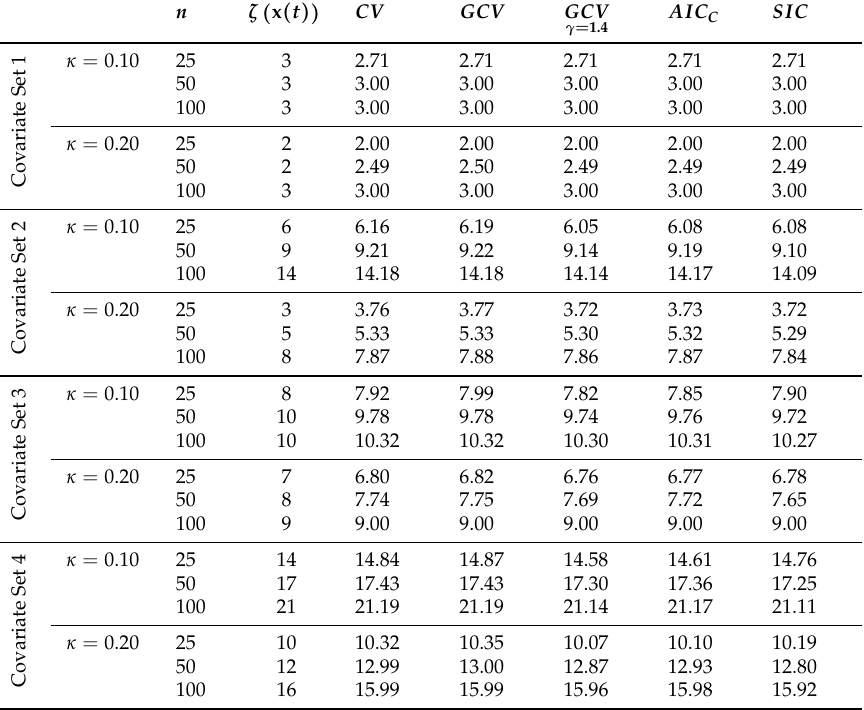
Figure 3. In each panel, the solid line represents the true parameter curve. The orange shaded region corresponds to the approximate expected value plus or minus two times the approximate standard deviation of the parameter curve estimator. Table 5. The average value of (6) computed across all simulated datasets for each simulation setting under parameter curve β 1 ( t )